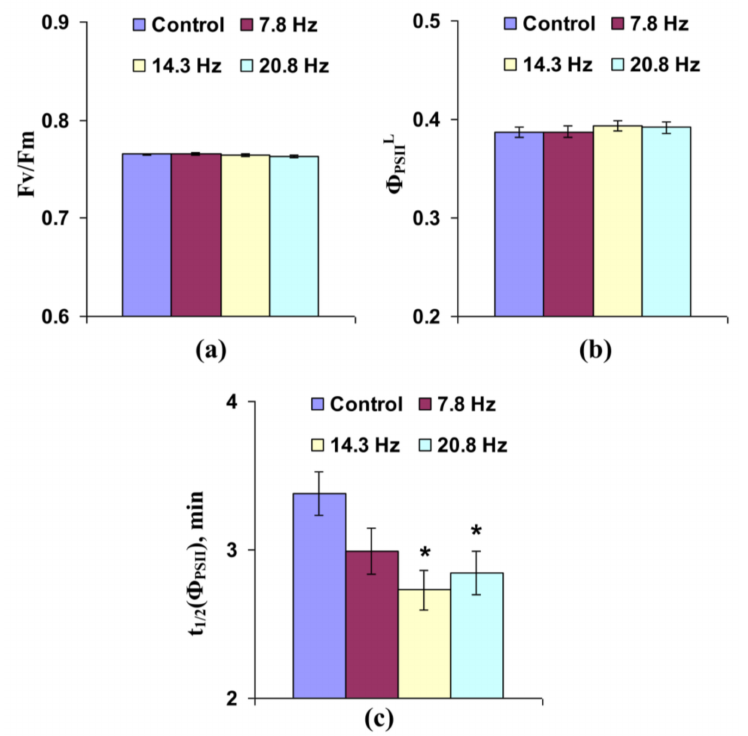
Figure 3. Influence of short-term treatment by artificial extremely low frequency magnetic field on potential quantum yield of photosystem II (Fv/Fm) ( a ), effective quantum yield of photosystem